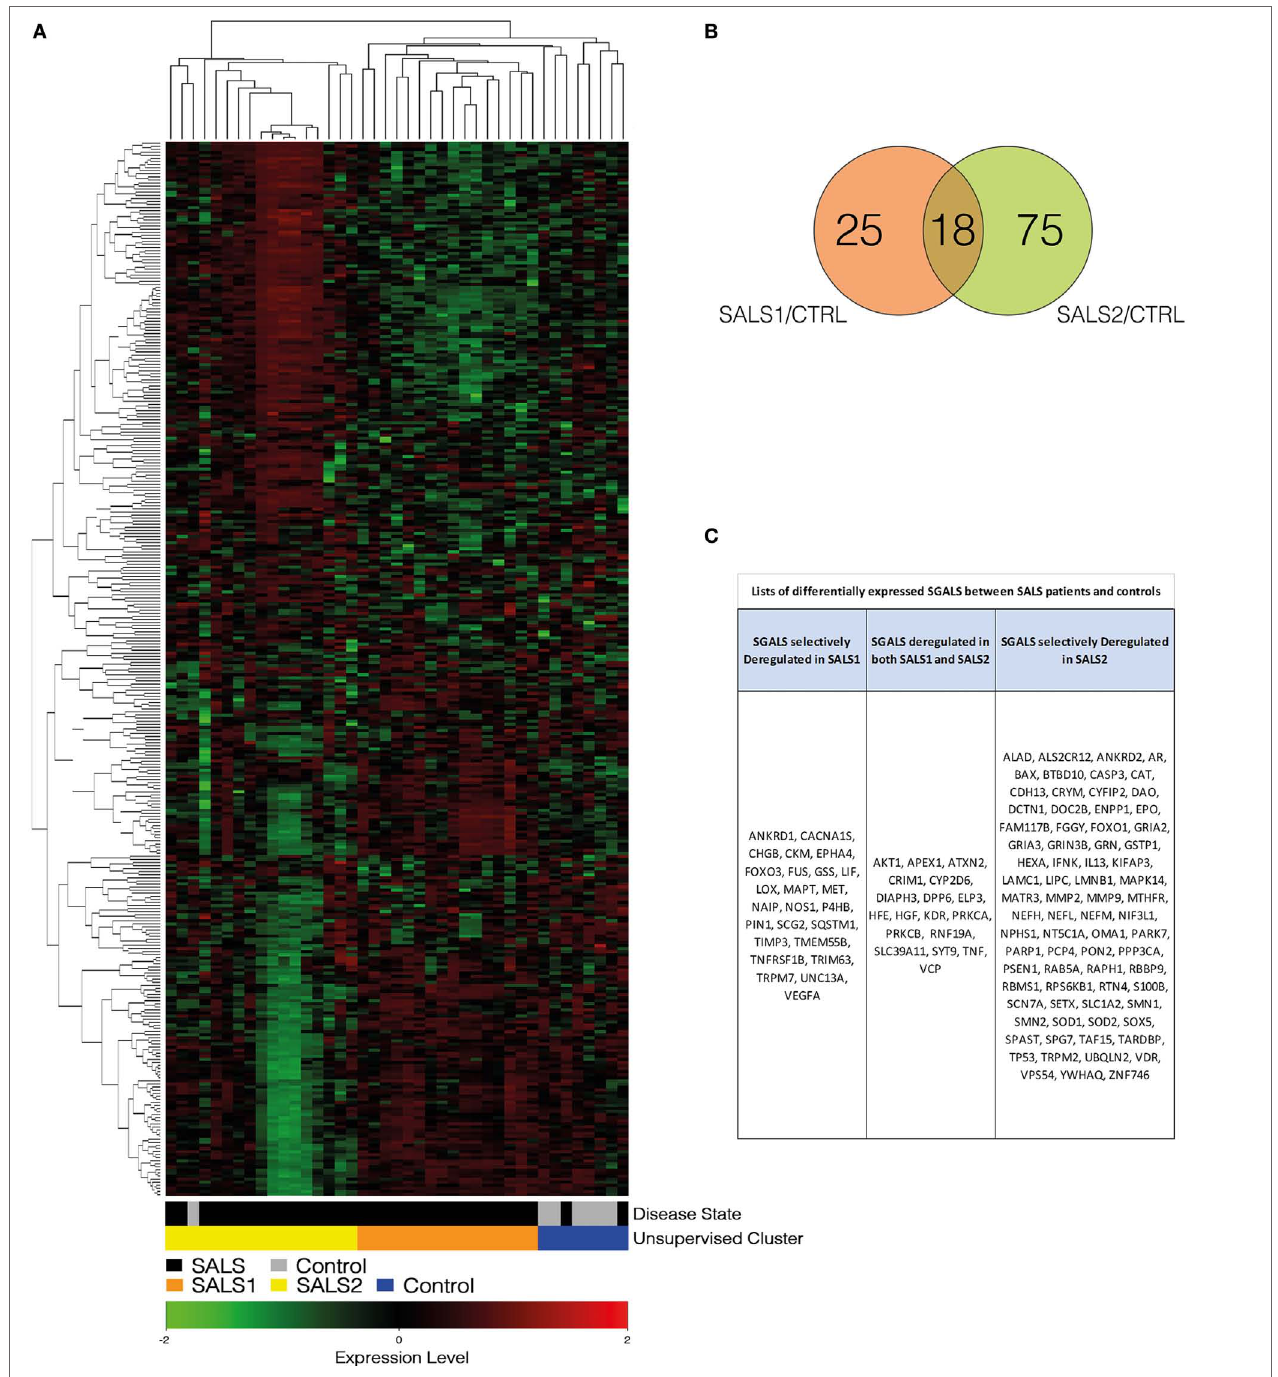
FiGUre 1 | Unsupervised hierarchical clustering of control and saLs patients . (a) Unsupervised hierarchical clustering was used to cluster control and SALS patients on the basis of the similarity in their SGALS expression profiles. In this two-dimensional presentation, each column represents a motor cortex from control or SALS patients, while each row represents a single gene probe. As shown in the color bar, red indicates upregulation, green downregulation, and black no change. In the dendrograms shown (left and top), the length and the subdivision of the branches display the relatedness of the expression of the probes and the motor cortex (top). (B) Venn diagrams of differentially expressed SGALS in SALS1 and SALS2 versus controls (Tables S2 and S3 in Supplementary Material). (C) Lists of the SGALS differentially expressed in each of the two SALS patient subsets in comparison with controls, identifying those commonly affected in both classes and those selectively affected in a single patient subgroup. Details are provided in Tables S1–S3 in Supplementary Material.